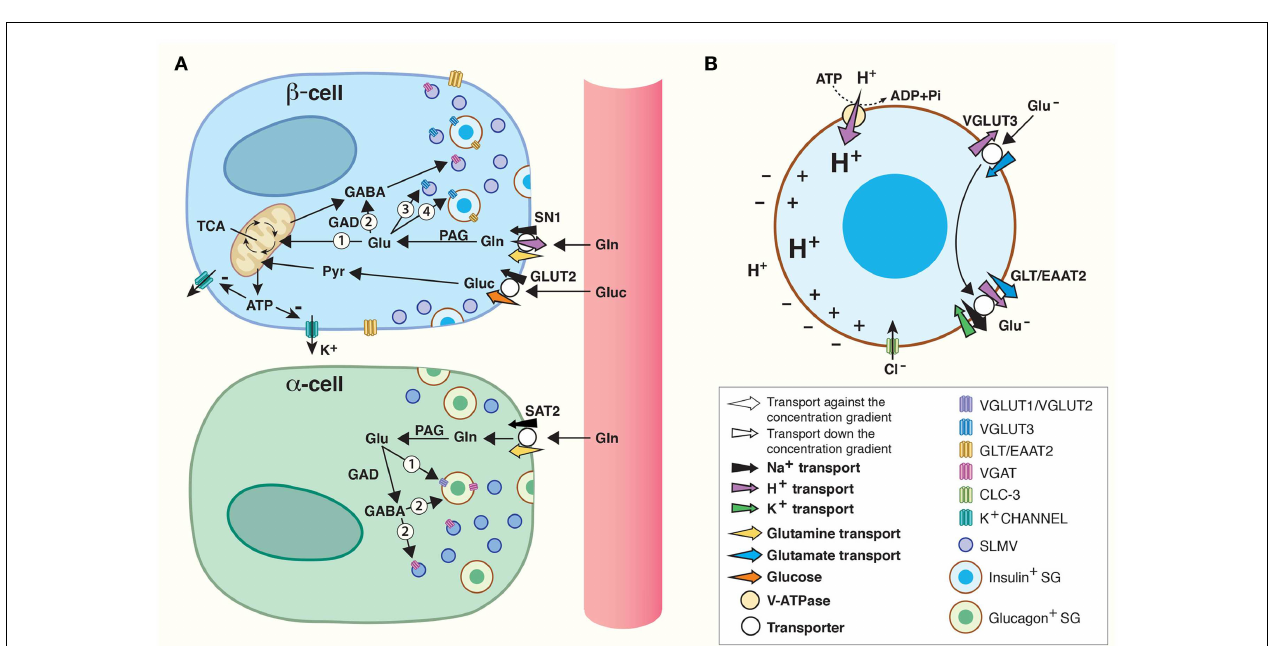
glutamate and/or GABA by PAG and GAD, respectively.The vesicular glutamate transporters (VGLUT) 1 and 2 andVGAT then transport glutamate (1) and GABA (2) into SLMVs and glucagon containing SG for exocytotic release. (B) VGLUT3-mediated transport of glutamate into SGs, followed by GLT/EAAT2-mediated transport out, contributes to maturation of insulin. A vacuolar (V)-ATPase generates a high electrochemical gradient for H + . Flux